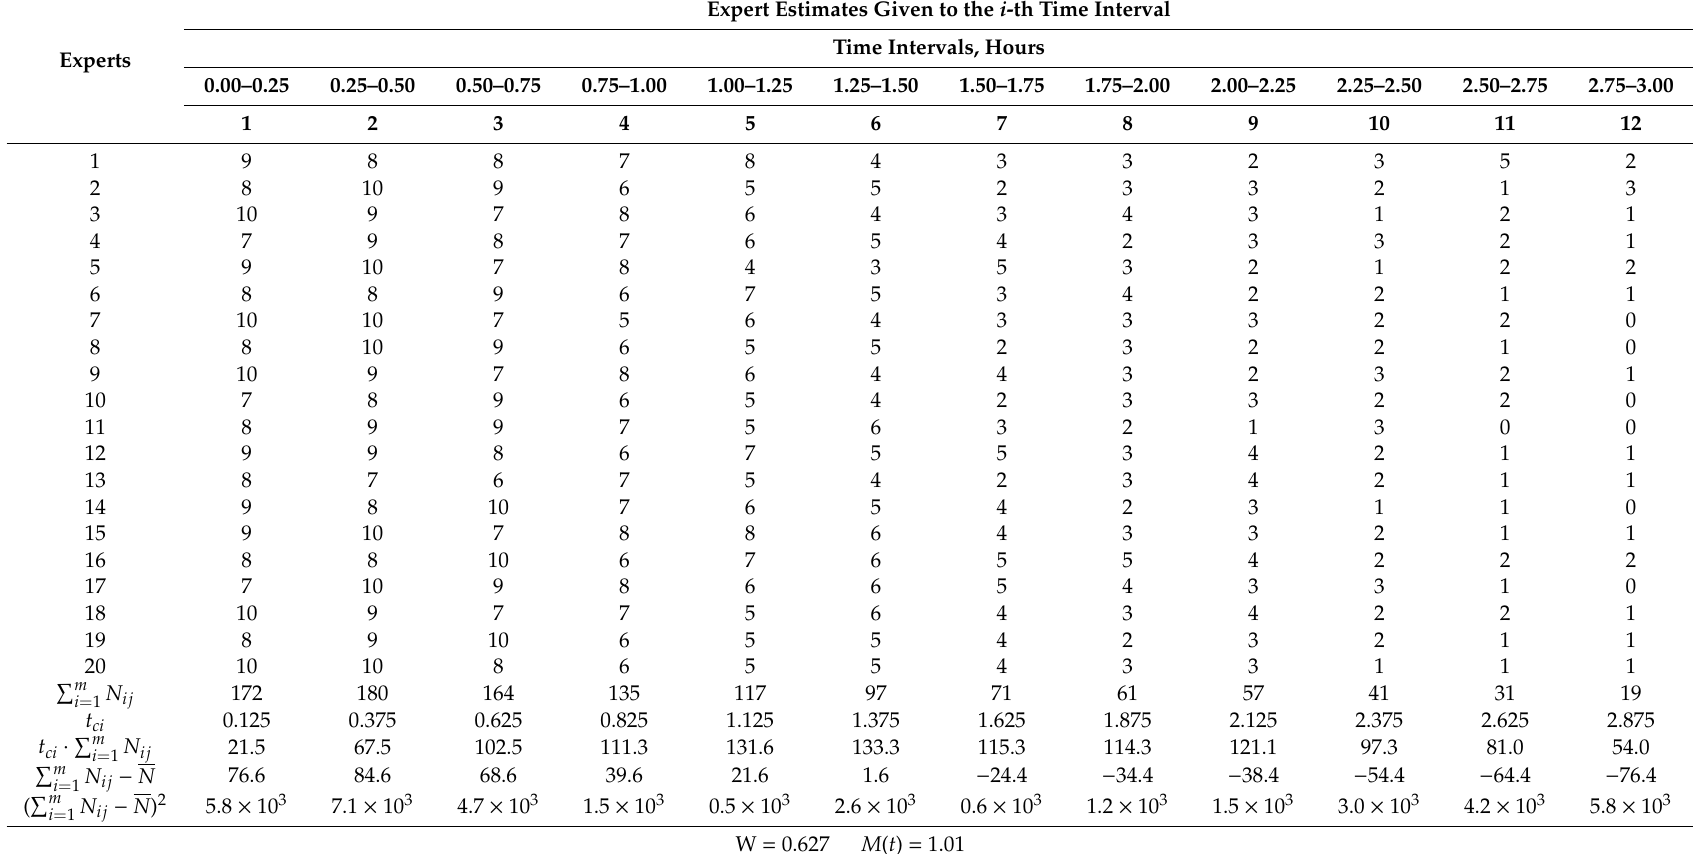
Table 1. The results of the expert survey to determine the time for obtaining information on